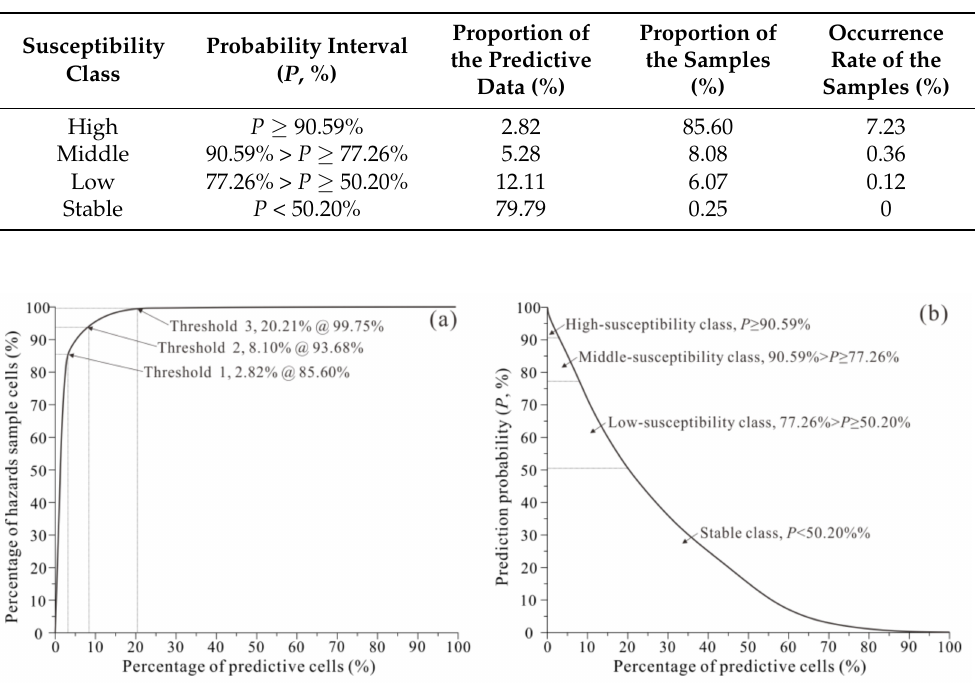
Table 5. Zonation of the MGM.